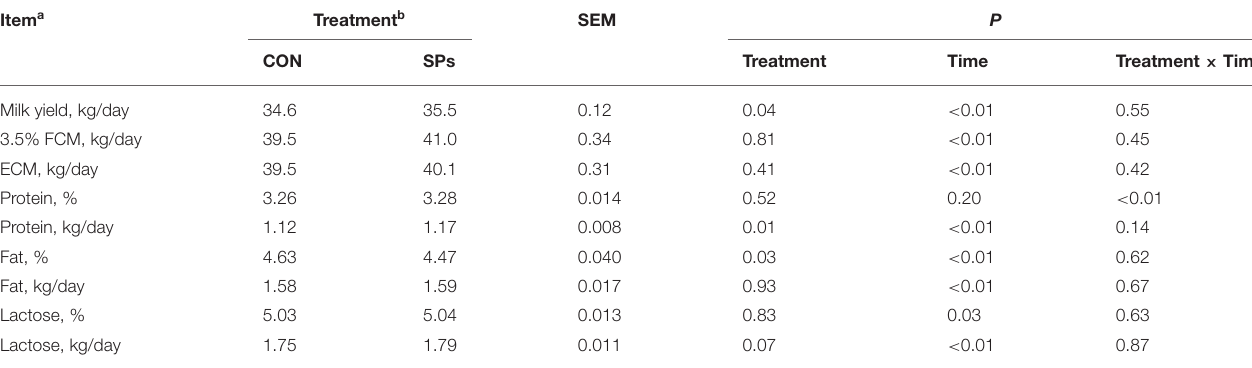
TABLE 5 | Effects of the dietary supplementation of soybean peptides (SPs) on milk yield and milk components in lactating dairy cows. Item a Treatment b SEM